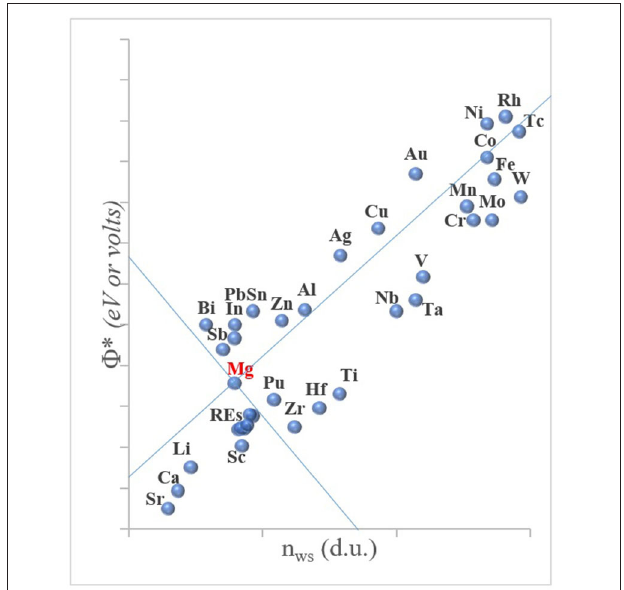
FIGURE 3 | A conceptual illustration of Φ * (eV) the chemical potential for electrons (equivalently, electronegativity, or the work function) vs. n WS (d.u., density unit) electron density at atomic cell (Wigner-Seitz) boundary (d.u., density units). The upper (north) and lower (south) sectors indicate the elements that can form intermetallics with Mg, and the left and right sectors involves the elements that do not (data adopted from the refs.: Miedema, 1973a; Abaspour and Cáceres, 2015